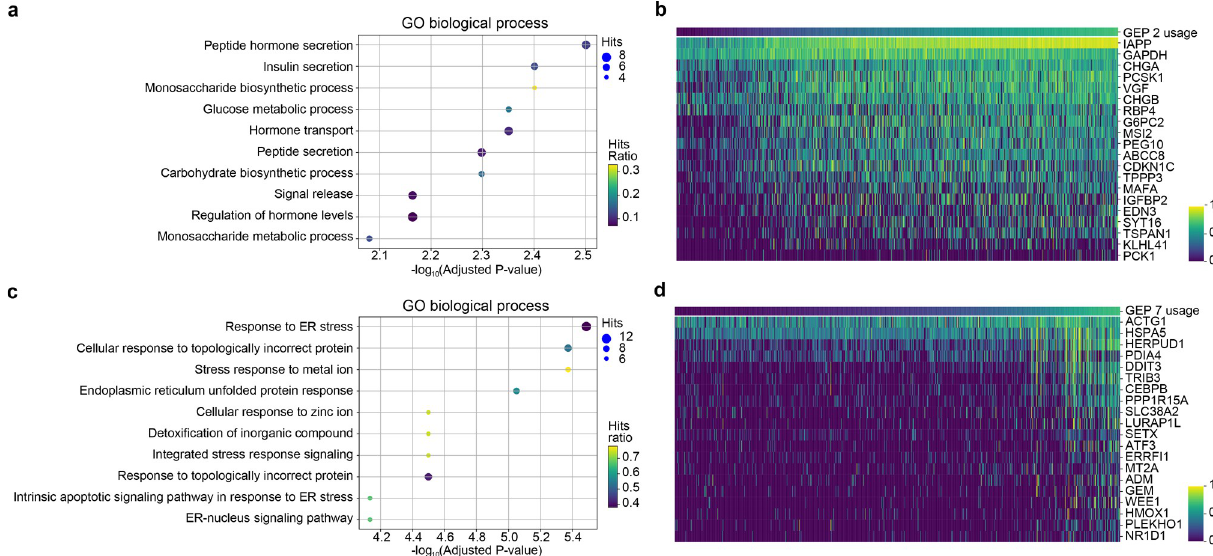
Fig 6. Enriched GO terms and top DEGs of GEP 2 and GEP 7 in the pancreatic islet dataset. (a) The top 10 enriched GO biological process terms using 26 significantly upregulated genes of GEP 2. (b) The expression levels of the top 20 DEGs of GEP 2 with the largest z-scores from the DEG test covaried with the inferred usage of GEP 2. (c) The top 10 enriched GO biological process terms using 84 significantly upregulated genes of GEP 7. (d) The top 20 DEGs of GEP 7 with the largest z-scores. Cells in b and d were sorted in increasing order based on the inferred cell usage of GEP 2 and GEP 7,